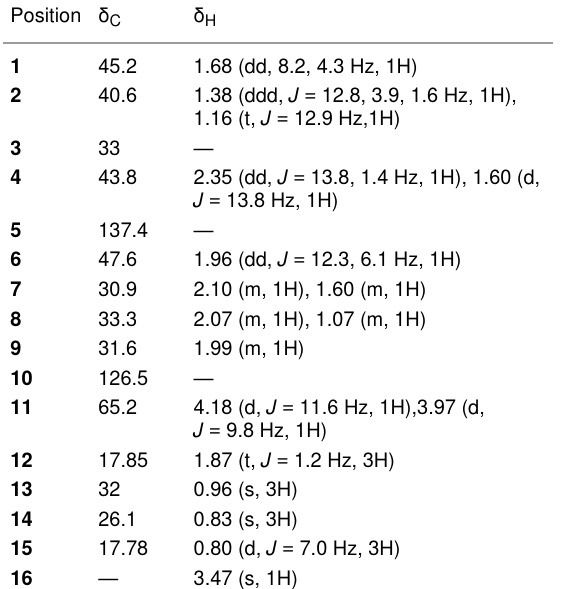
Table 1: 1 H NMR (400 MHz, CDCl 3 ) and 13 C NMR (100 MHz) data for compound 1 in CDCl 3